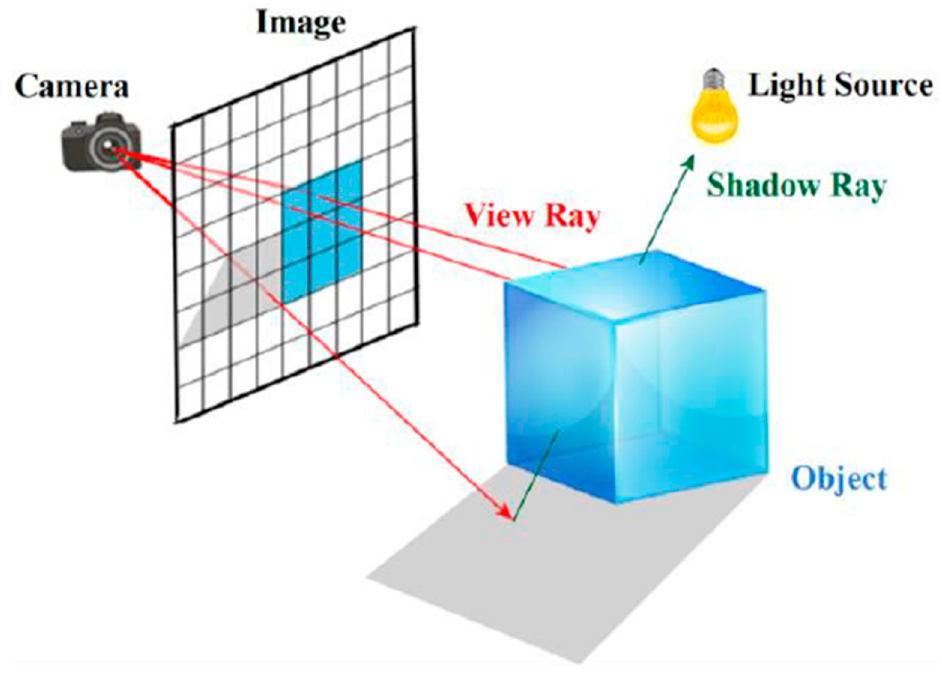
Figure 2. Raytracing’ principle [29].